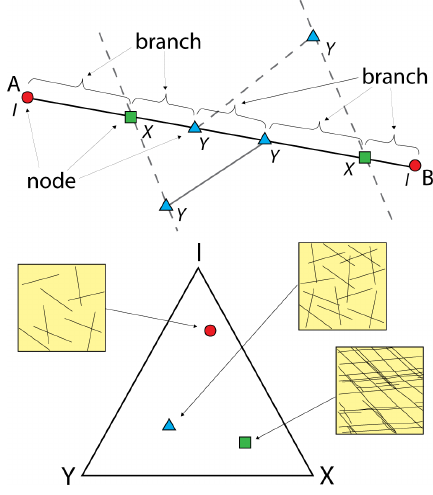
Figure 4. Schematic image outlining the principal method applied for fracture analysis (Sanderson and Nixon, 2015). Branches and nodes are shown on fracture trace (A–B): I-nodes (red circles); Y- nodes (blue triangles); X-nodes (green squares). Proportions of I-, Y- and X-nodes may be plotted on a ternary plot to visualise differ- ent fracture network types (after Manzocchi,